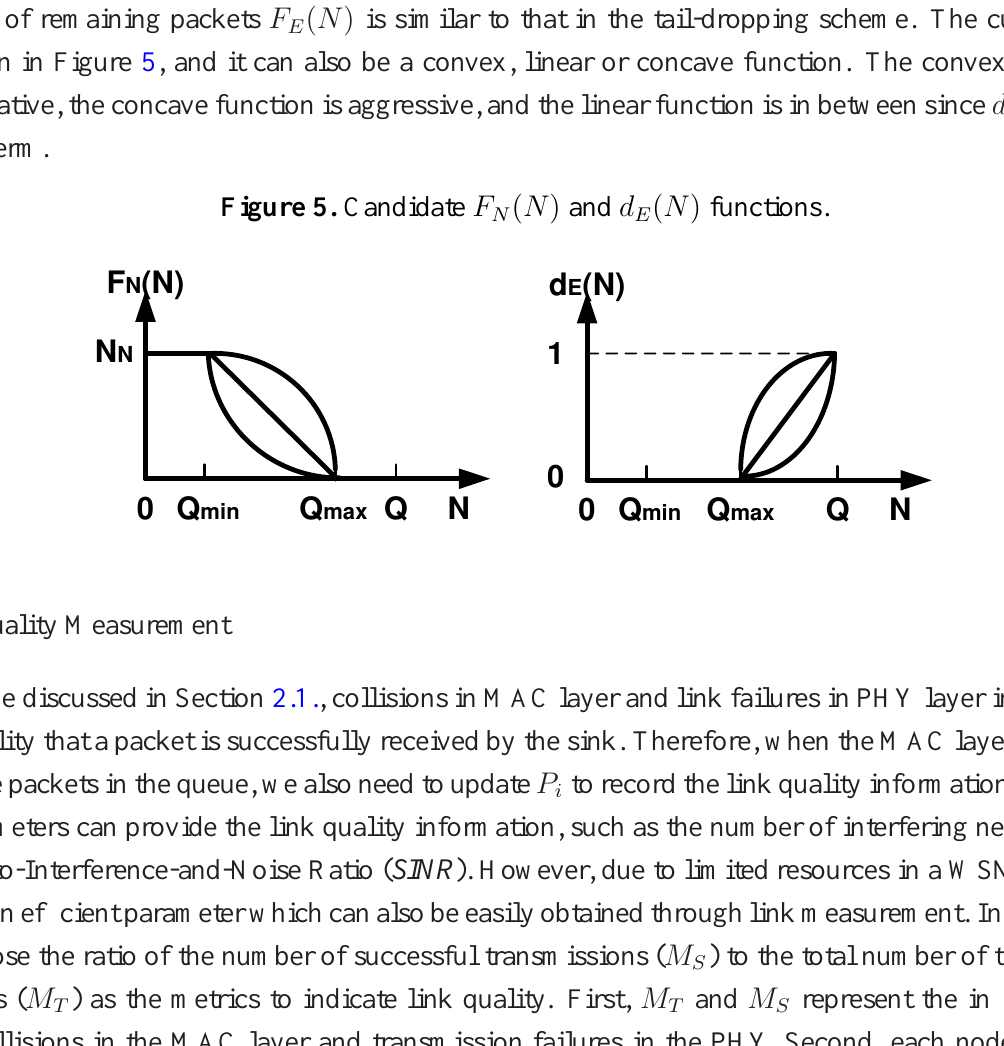
Figure 5. Candidate F